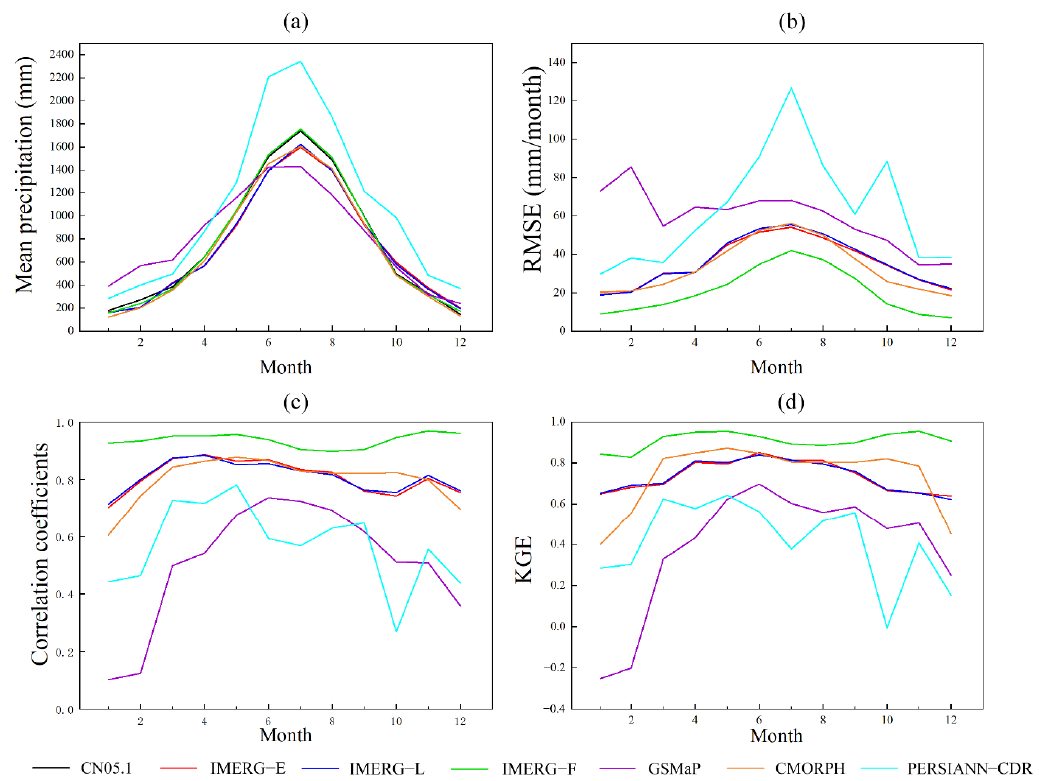
Figure 5. Monthly variations in statistics. ( a ) Mean precipitation (mm); ( b ) RMSE (mm/month); ( c ) CC; and ( d ) KGE.